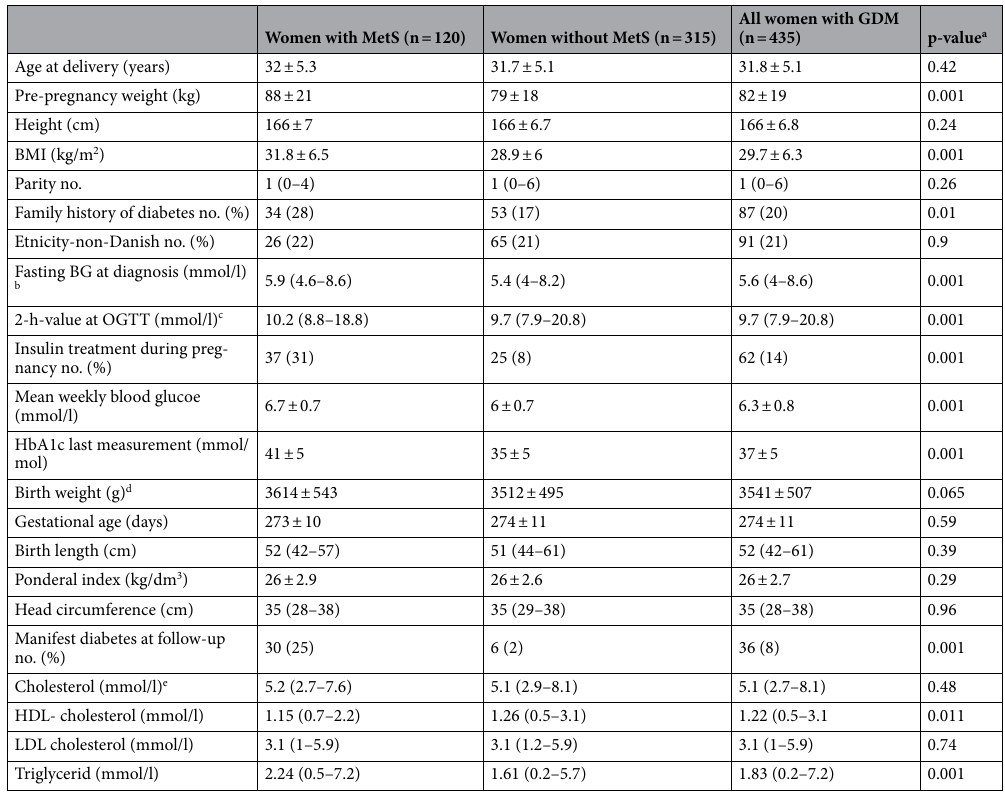
Table 1. Basal characteristics and pregnancy data of 435 women with GDM by subsequent metabolic syndrome. Data are given as mean ± SD / median (range) or no. (% of column). BG blood glucose. a Women with vs. without metabolic syndrome. b Data on fasting-BG in 172 women. c Data on 2-h-BG in 427 women. d Data on neonatal anthropometrics in 428 women. e Data on lipidemia in 250